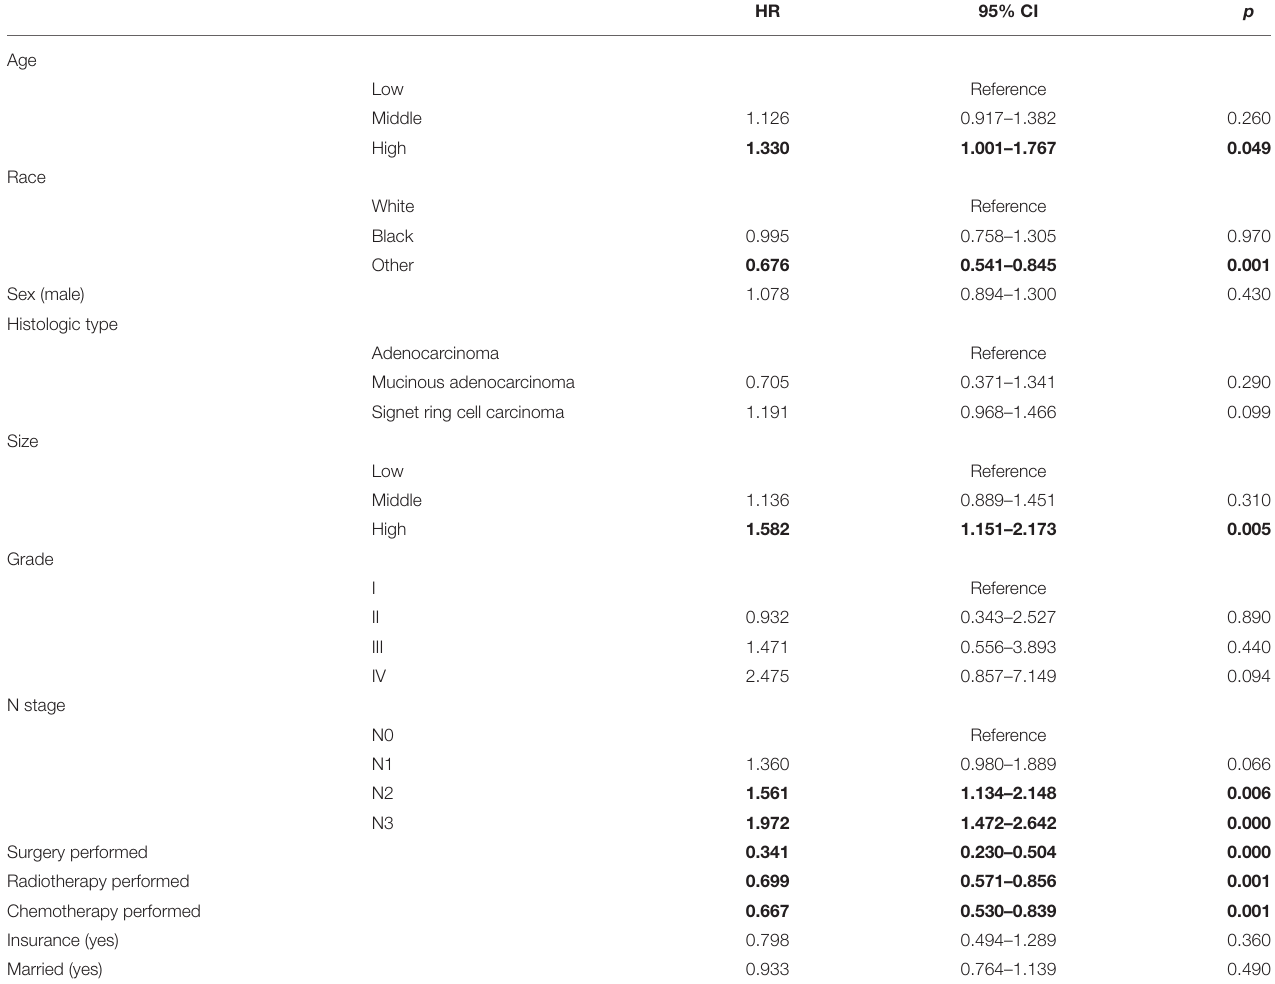
TABLE 4 | Multivariate competing risk model analysis of CSS for each variable in T4aN0-3M0 patients with T4aN0-3M0 GC in the training